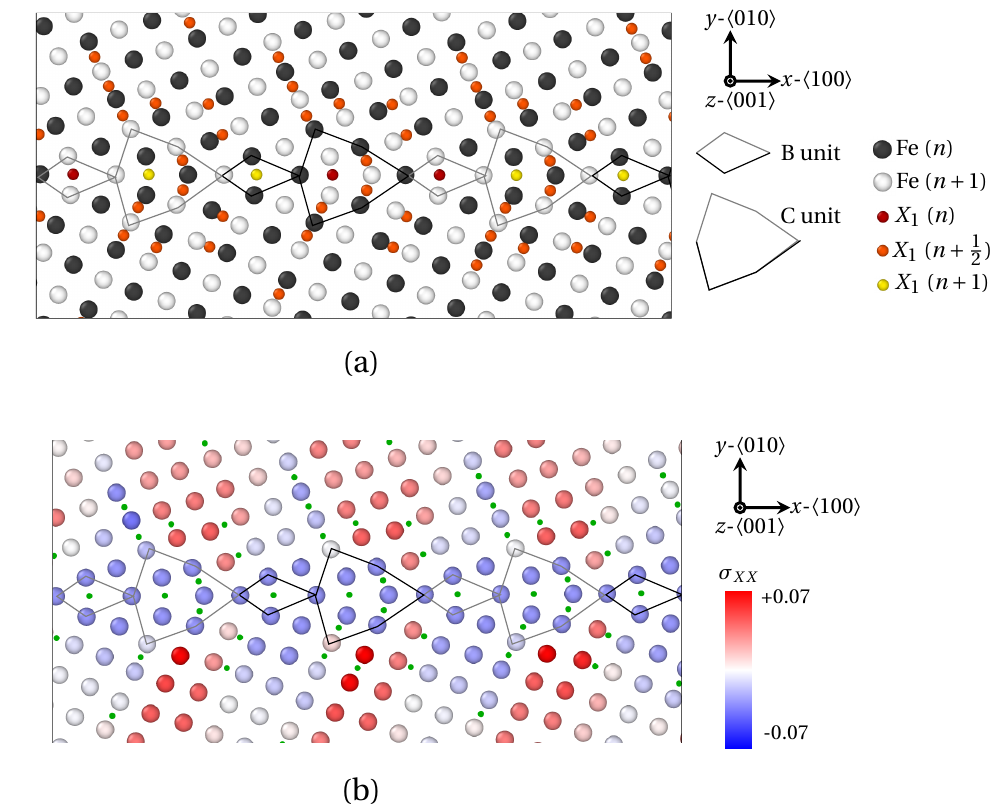
Figure 9. Segregation of X 1 atoms at Σ 29 ( 730 ) ( θ = 46.40 ◦ ) as provided by QA simulations ( t = 400). ( a ) Atoms positions. ( b ) Strain field of Fe atoms in the (cid:104) 100 (cid:105) direction. X 1 atoms are spotted by green dots. B and C structural units are materialized by black ( n plane) and gray ( n + 1 plane)